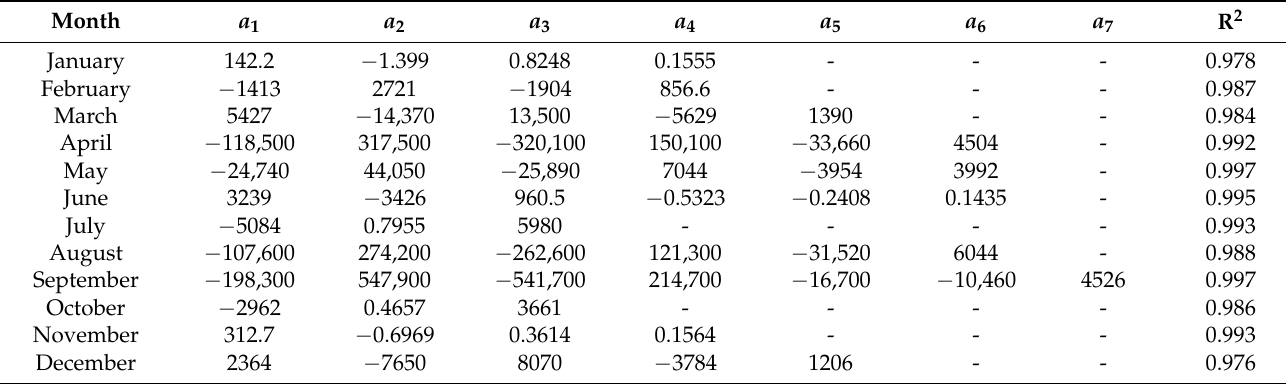
Table A8. Specific parameters of Wulong